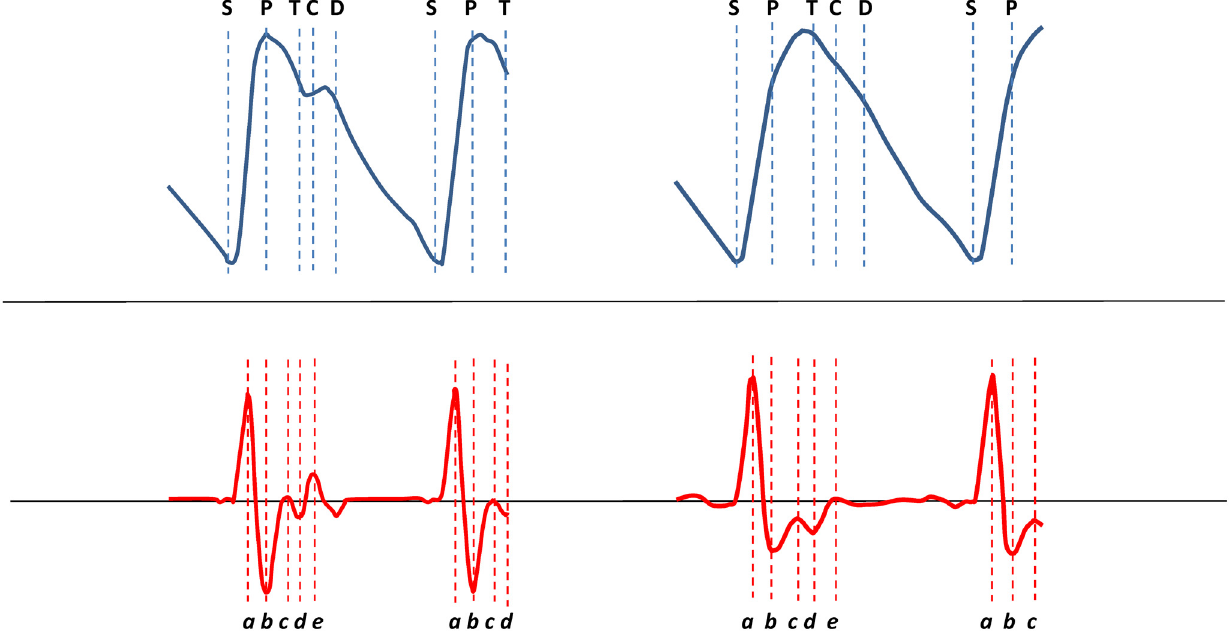
Fig 1. Digital photoplethysmograms and acceleration photoplethysmograms. Authentic digital photoplethysmograms (upper panels) of a 33-year old healthy woman (left panel, heart rate 65 bpm, aging index -0.87) and a 66-year old healthy man (right panel, heart rate 61, aging index -0.09). S = starting point of systole; P = peak of percussion wave; T = tidal wave; C = incisura wave; D = dicrotic wave. Note the absence of a distinct incisura and dicrotic notch in the right plethysmogram, and differences in negative amplitudes of b and d peaks in the acceleration plethysmograms (lower panels).